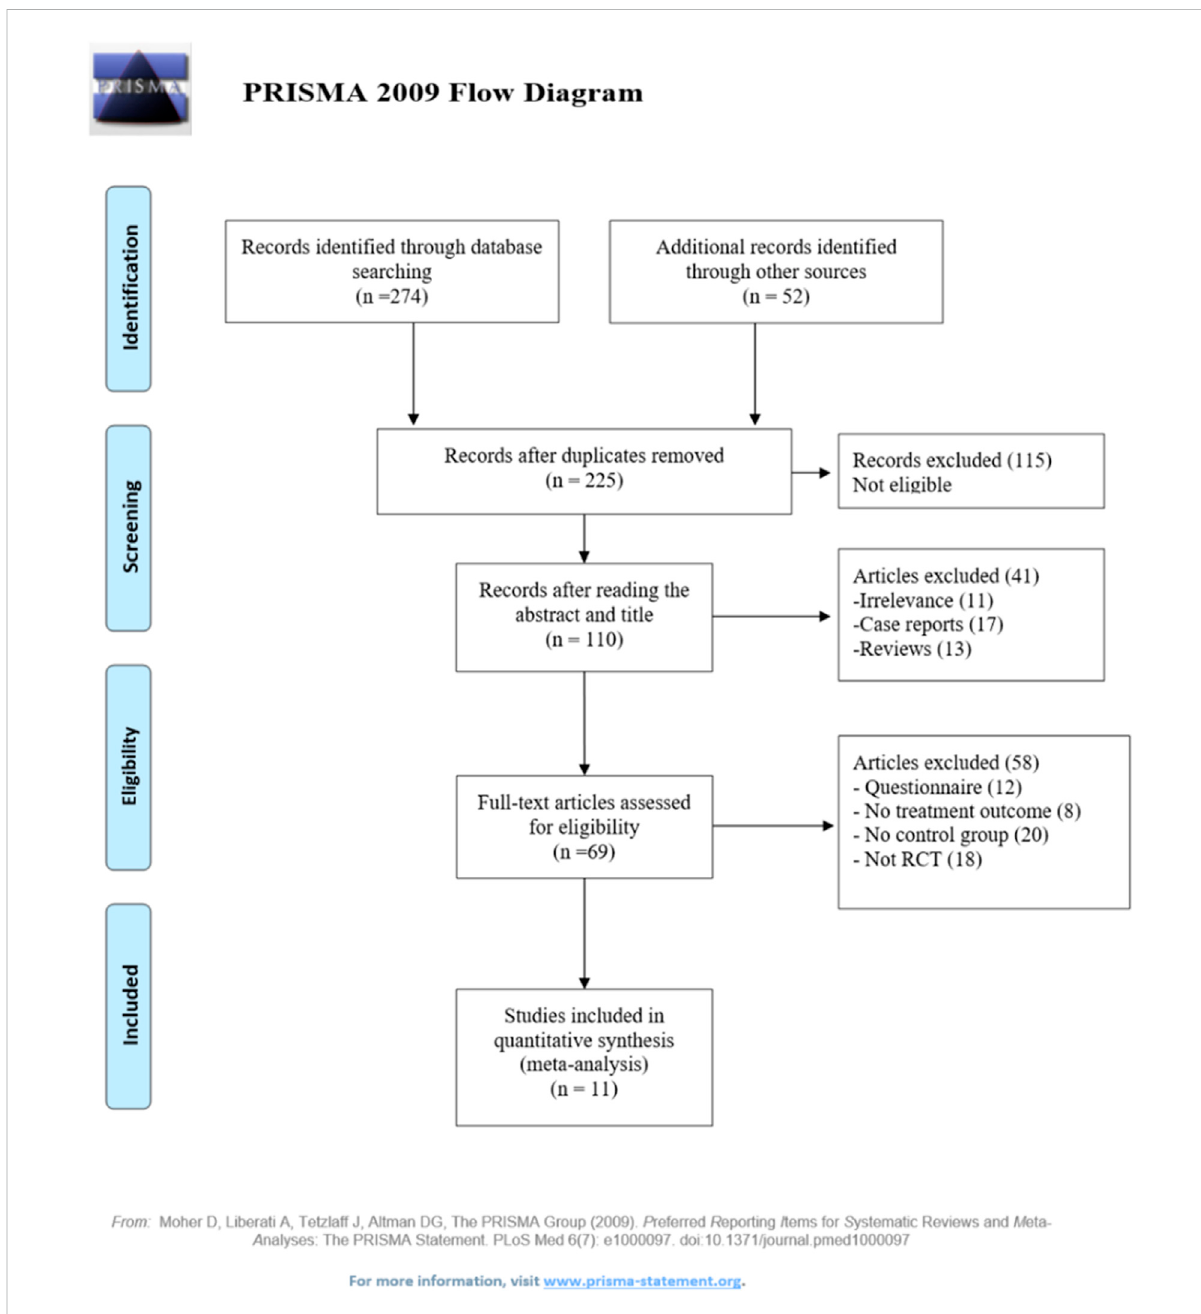
FIGURE 1 PRISMA fl owchart of study selection and identi fi cation